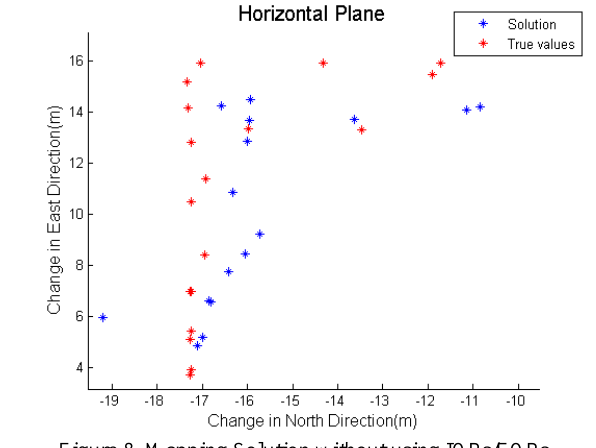
Figure 8. Mapping Solution without using IOPs/EOPs Correction step